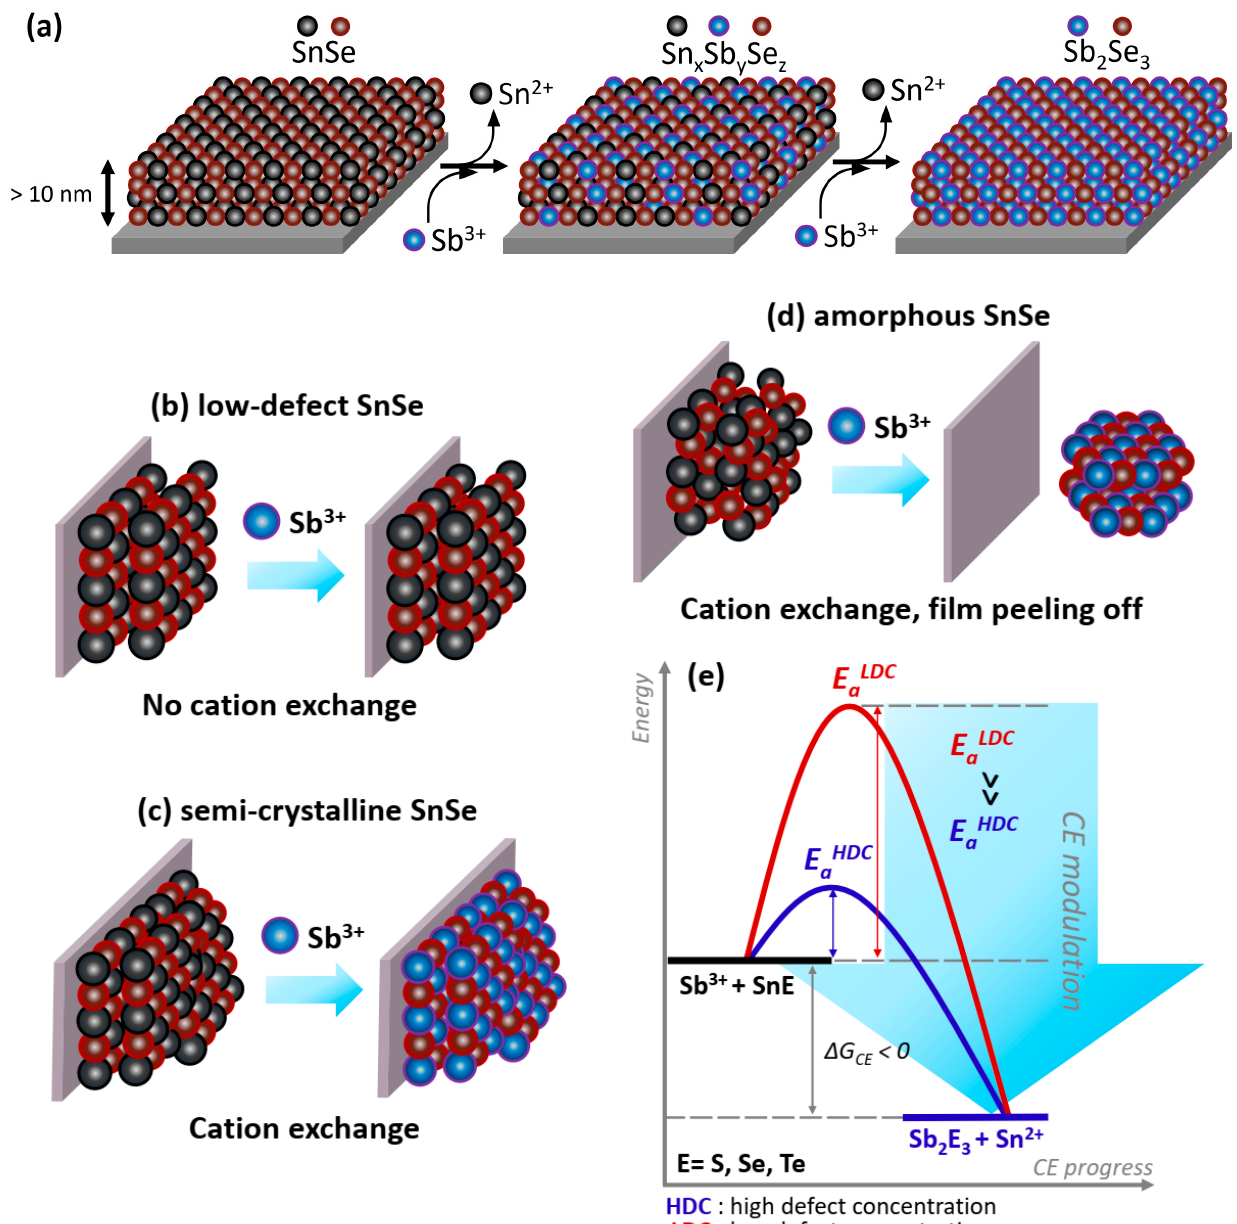
Figure 4. ( a ) Schematic illustration for phase transition induced by solution-assisted cation-exchange reactions. ( b – e ) Schematic way to control the transformation of extended solids attached to the substrate.